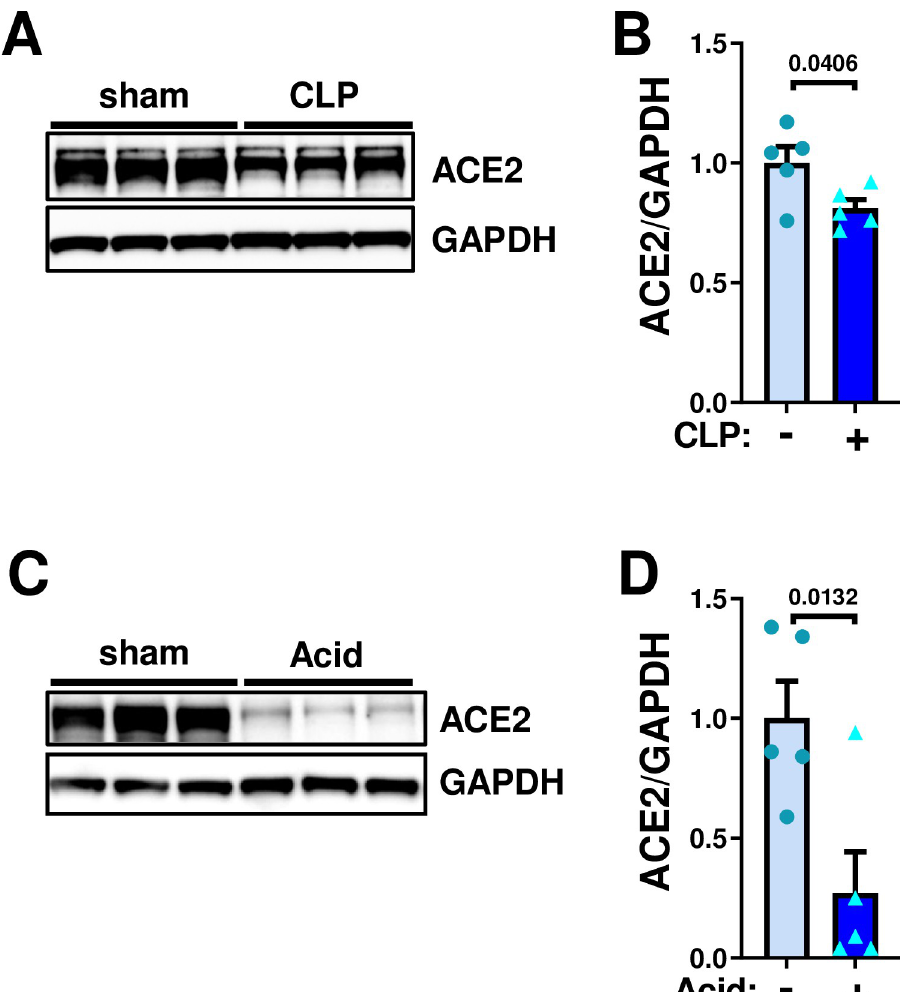
Fig 1. Downregulation of ACE2 expression in mouse lung under sepsis- or acid aspiration-induced lung injury. A-B , Protein expression of ACE2 in mouse lungs under sepsis at 48 hours after introducing cecal ligation puncture (CLP)-induced lung injury. Representative Western blot ( A ) and quantification of ACE2 protein abundance ( B ); sham control (n = 5) and CLP surgery (n = 5). C-D , Protein expression of ACE2 in mouse lungs at 24 hours after intra- tracheal instillation of acid in mice (0.02M HCl, 50 μ l per body). Representative Western blot ( C ) and quantification of ACE2 protein abundance ( D ); sham control (n = 5) and acid inhalation (n = 5). All values are means ± SEM. Two- tailed unpaired